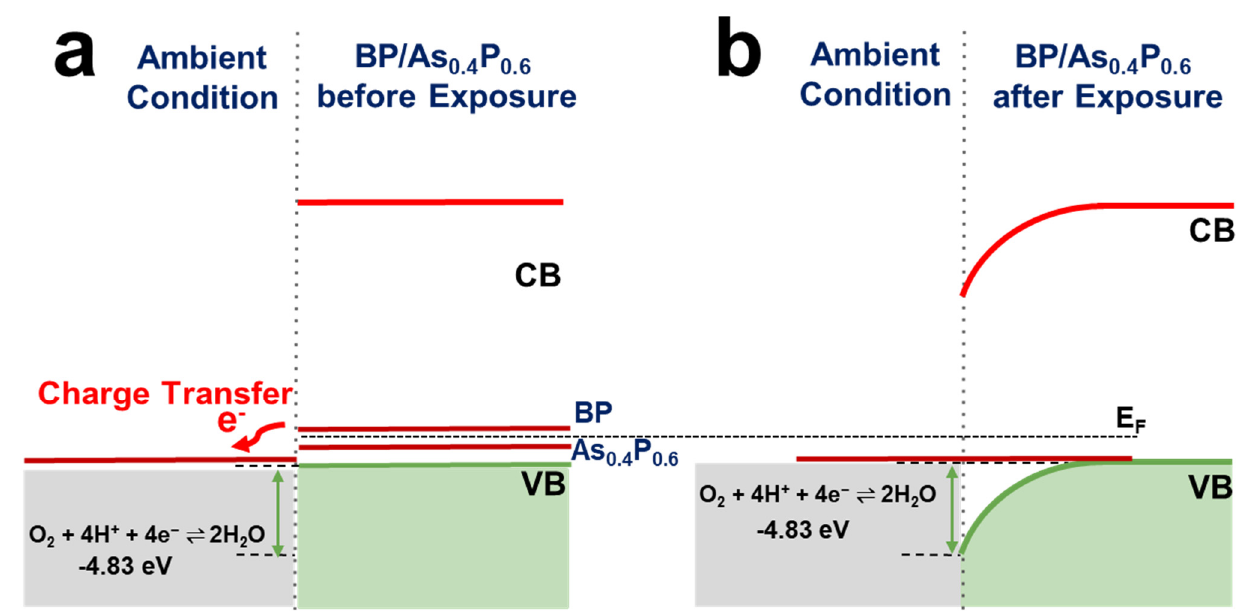
Figure 5. Band diagrams explaining the electron exchange between BP/As x P 1 − x material and the aqueous redox couple ( a ) before and ( b ) after exposure to ambient conditions.